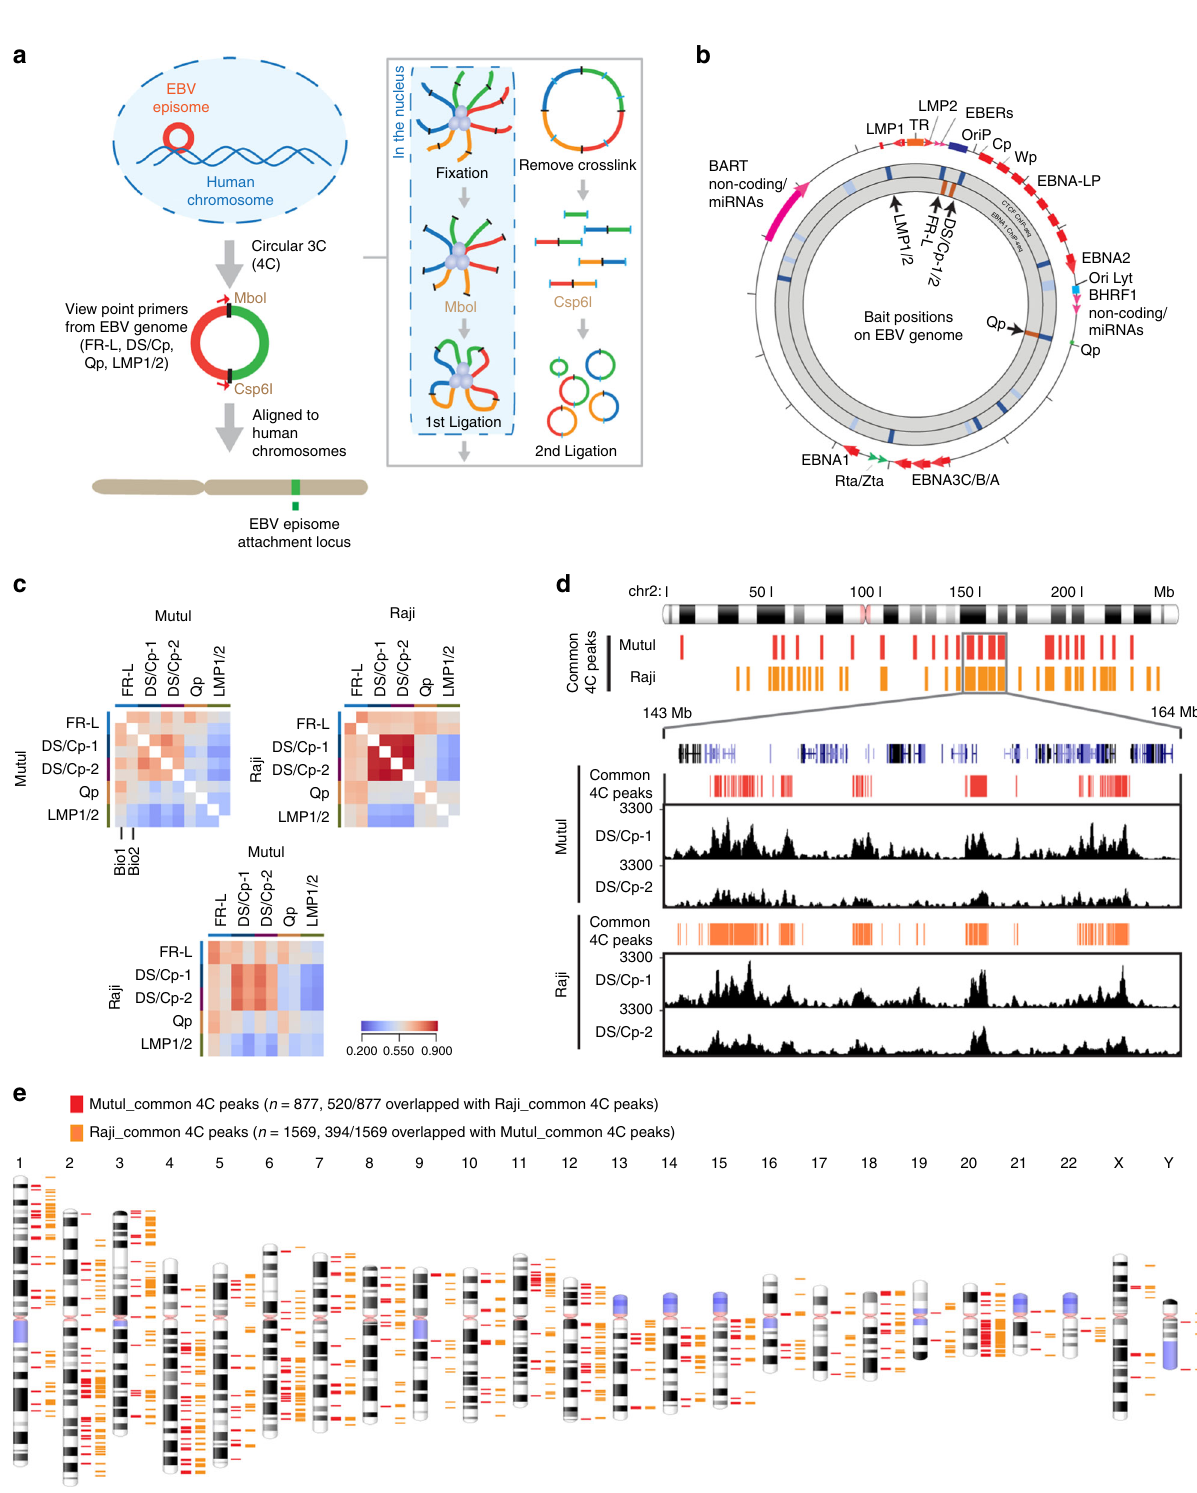
Fig. 1 4C analysis of EBV-host DNA interactome. a The 4C experimental procedure. b Baits positions at FR-L (Left), DS/Cp, Qp, and LMP1/2, on EBV genome. The positions of EBV genes and binding sites for CTCF and EBNA1 are indicated. c Heatmap showing the Pearson ’ s correlation coef fi cients of 4C- seq scores for 10 kb non-overlapped windows between baits from same (top) or different strains (bottom). d Example of 4C peaks for MutuI (DS/Cp-1,2) and Raji (DS/Cp-1,2) at the chr2: 143 – 164 Mb region with 10 kb resolution. e The 877 common 4C peaks for MutuI (red bars) and 1569 common 4C peaks for Raji (orange bars) are loaded on human all chromosomes with 10 kb